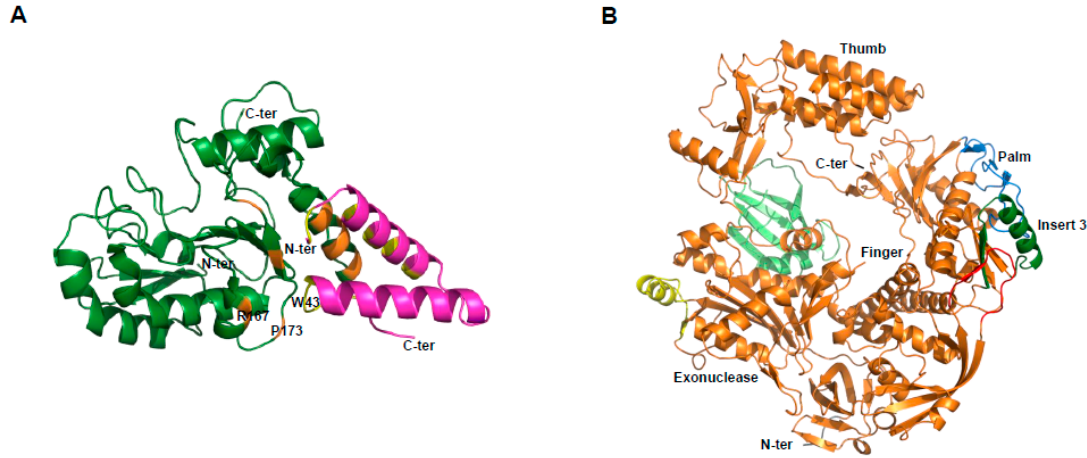
Figure 4. Crystallographic structures of D4/A20 1-50 and the DNA polymerase of VACV. ( A ) D4 is depicted in dark green, and A20 1-50 in magenta. In orange and yellow are shown the residues of D4 and A20, respectively, critical for the D4/A20 contact. Residues R167, P173 of D4, and W43 of A20 are indicated; ( B ) view of the domain organization. The classical palm, thumb, finger, and exonuclease domains of family B polymerase are shown. The various poxvirus-specific structural insertions are depicted in color. Some residues in insert 3 (dark green) were shown to be critical for E9/A20 interaction [71].